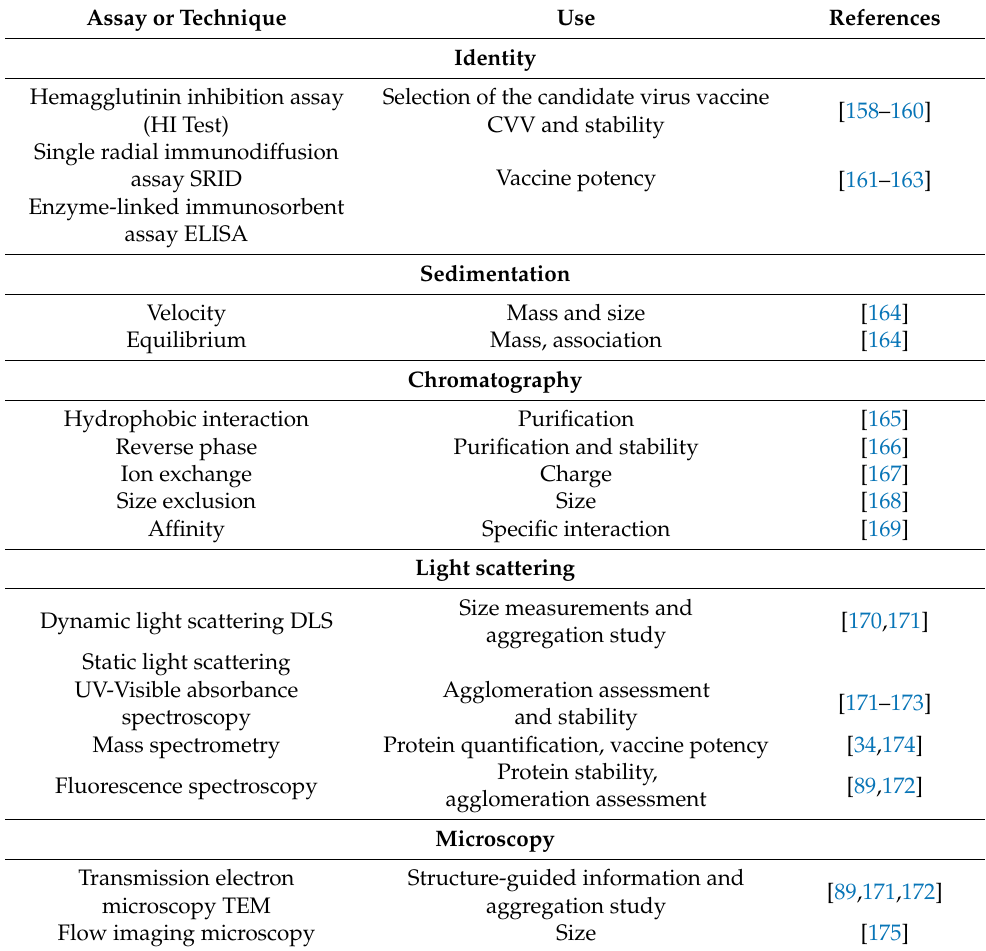
Table 4. Techniques in vaccine development and